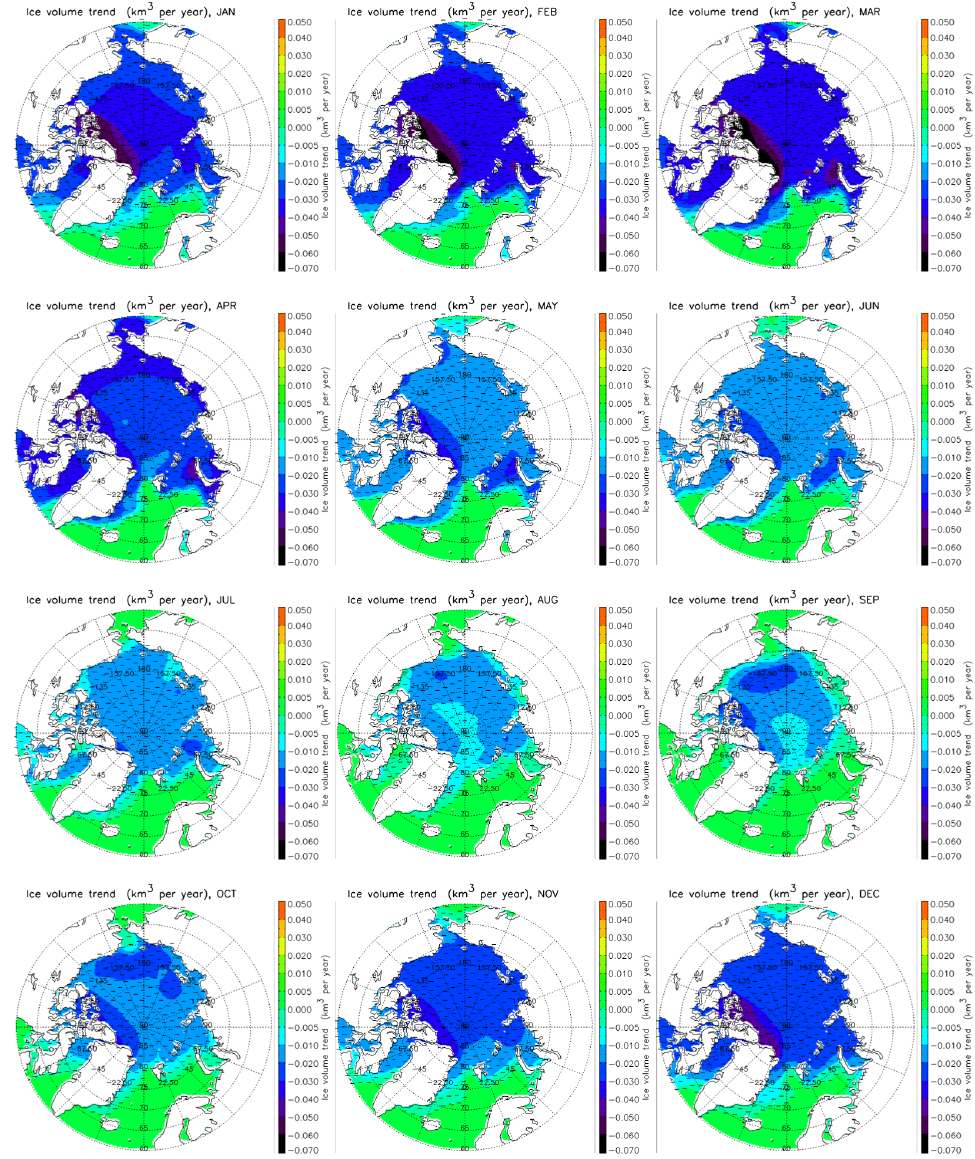
Figure 12. Spatial distributions of Arctic monthly mean SIV trends over 1982–2020 for the months of January through December. January through